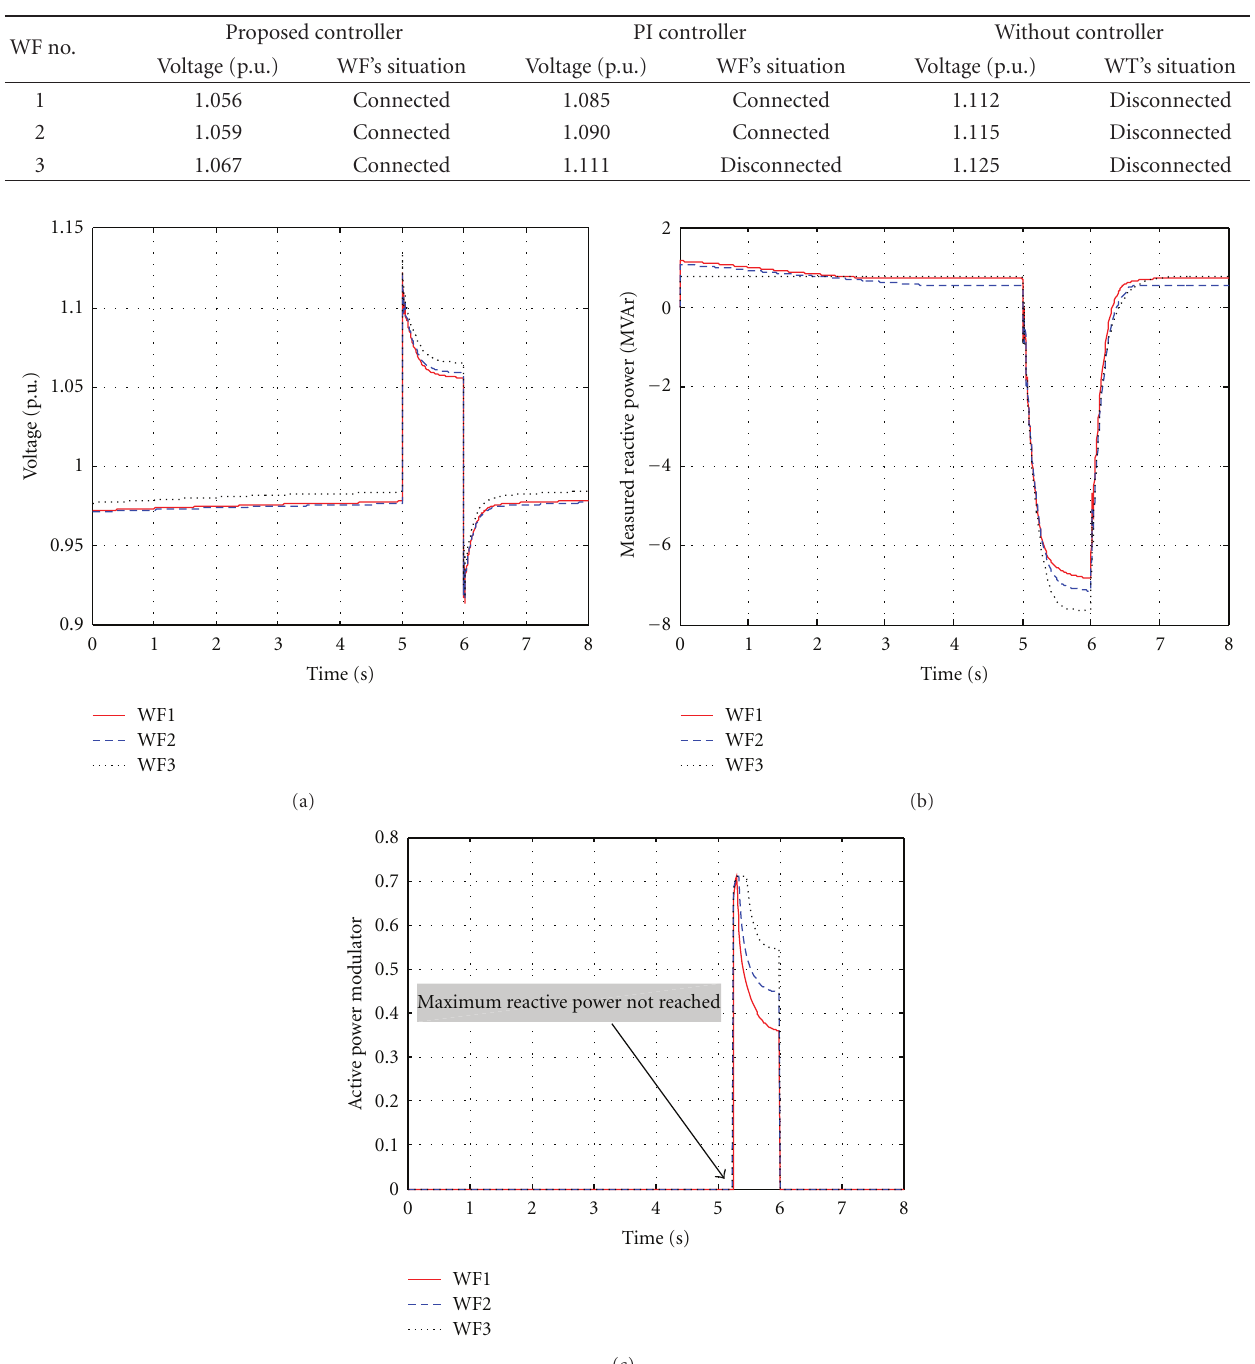
Table 4: Results obtained with PI controller and without controller For All WFs.